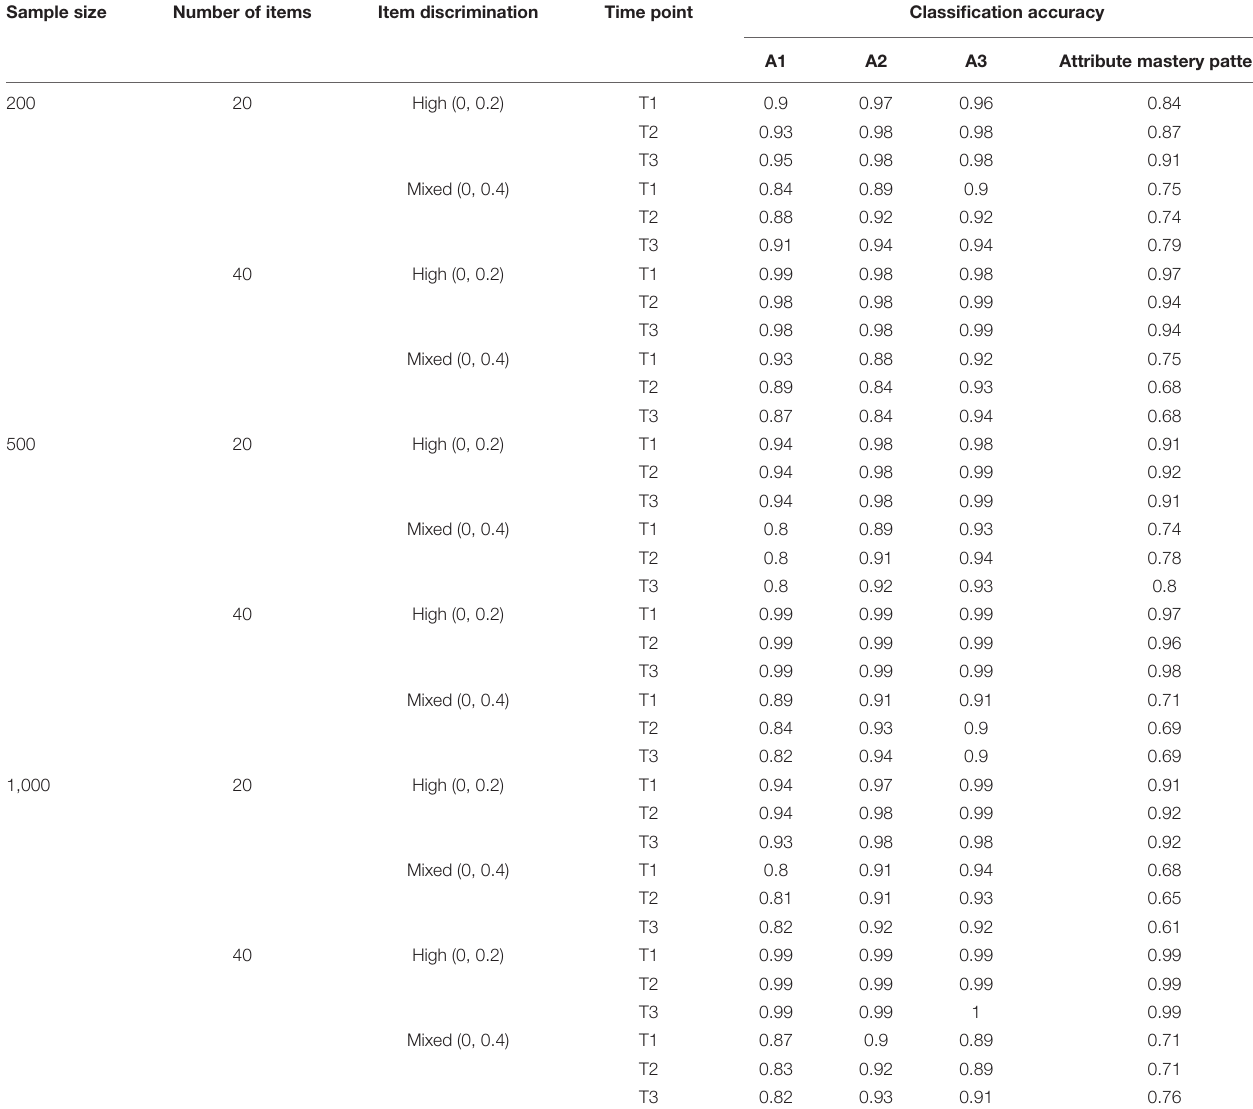
TABLE 4 | Attribute classification accuracy ( k = 3). Sample